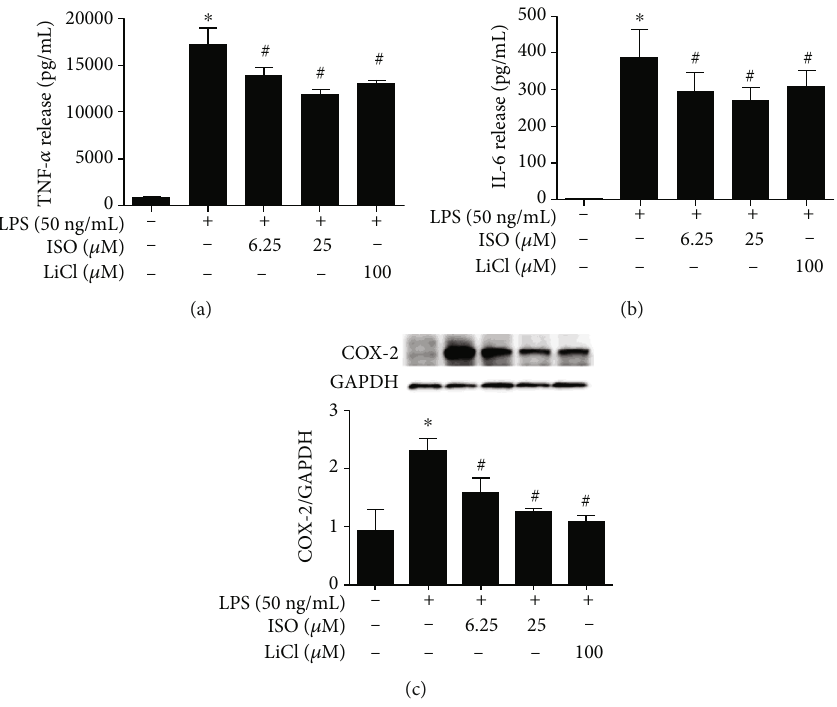
Figure 1: E ff ects of isoorientin on in fl ammatory cytokines and COX-2. RAW264.7 cells were treated with isoorientin (ISO) (6.25 and 25 μ M) or LiCl (100 μ M) for 30min and then stimulated with LPS (50 ng/mL). After 8h of stimulation, the cell supernatants were collected, and the levels of TNF- α (a) and IL-6 (b) were detected by ELISA ( n = 4 , 4 replicates). The cells were collected to measure the expression of COX-2 by Western blotting ( n = 3 , 3 independent experiments) (c). The data were expressed as mean ± SEM . ∗ P < 0 : 05 versus the control group, # P < 0 : 05 versus the LPS